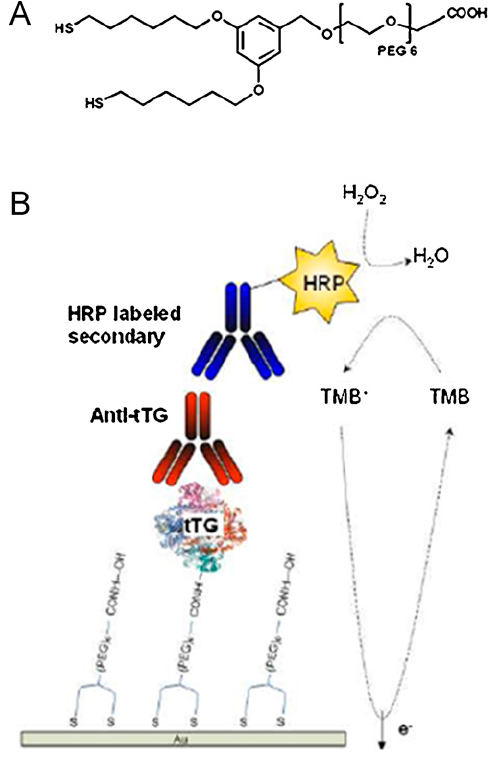
Figure 6. ( A ) (22-(3,5-bis((6 mercaptohexyl)oxy)phenyl)-3,6,9,12,15,18,21-heptaoxadocosanoic acid dithiol PEG-6 carboxylate (DT2); ( B ) Schematic of the electrochemical immunosensor assay architecture [70]. Copyright 2011. Reproduced with permission from Elsevier B. V.